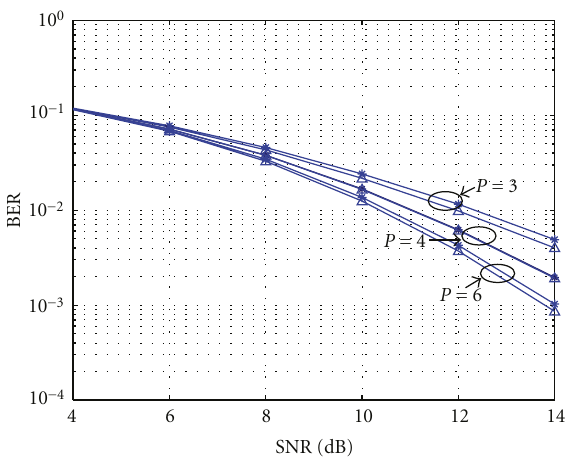
Figure 7: Performance of the MRP marked by Δ and the SFBC in [12] marked by ∗ for the MIMO-OFDM system with N t = 2, N r = 1, N c = 512, and δ = (cid:6) 512 /P (cid:7) in COST207 typical urban scenario.